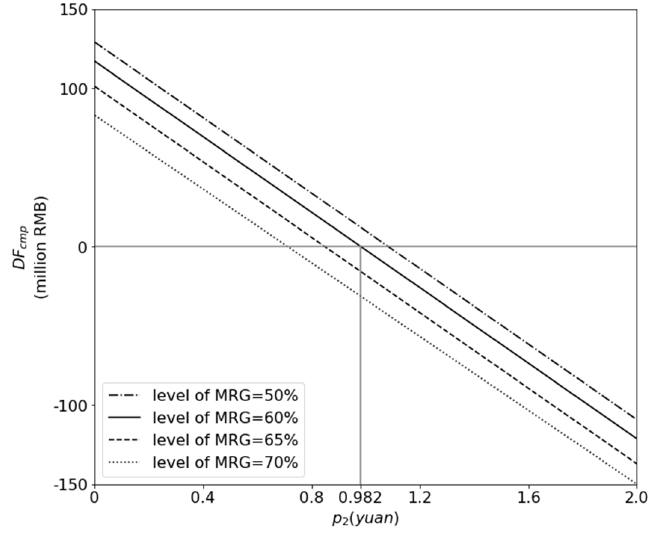
Figure 6. Relationships between the decision factor and the unit price of the phase II project.